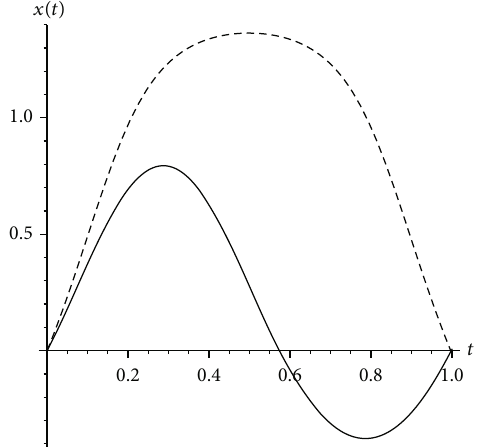
Figure 17: Graphs x ð t Þ for solutions of problem (31) and (37), α ≈ 3 : 367 , α ≈ 4 : 214